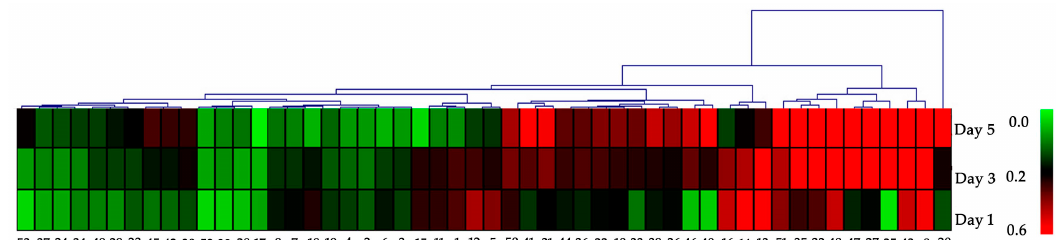
Figure 3. The heat map visualization of differential abundance of the identified 52 proteins in B. acuminata petals. The upregulated and downregulated proteins are indicated from red to green, respectively. The color scale is shown at the left of the cluster.